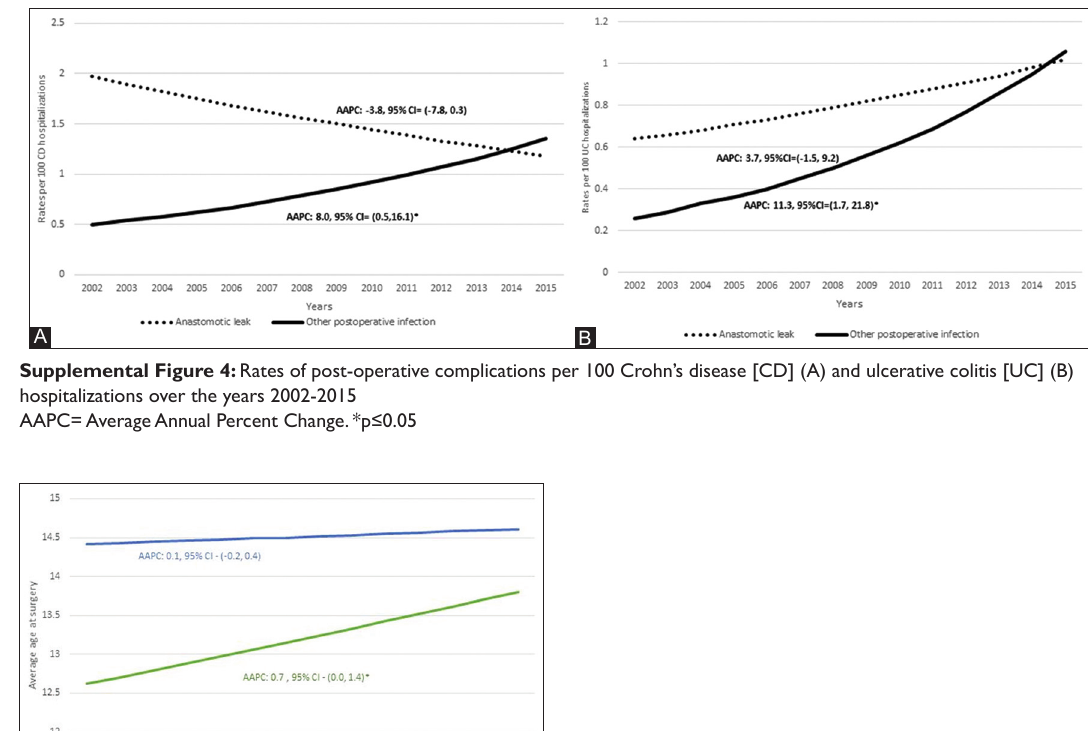
10 of 10 Int J MCH AIDS 2022;11(1):e522. https://doi.org/10.21106/ijma.522